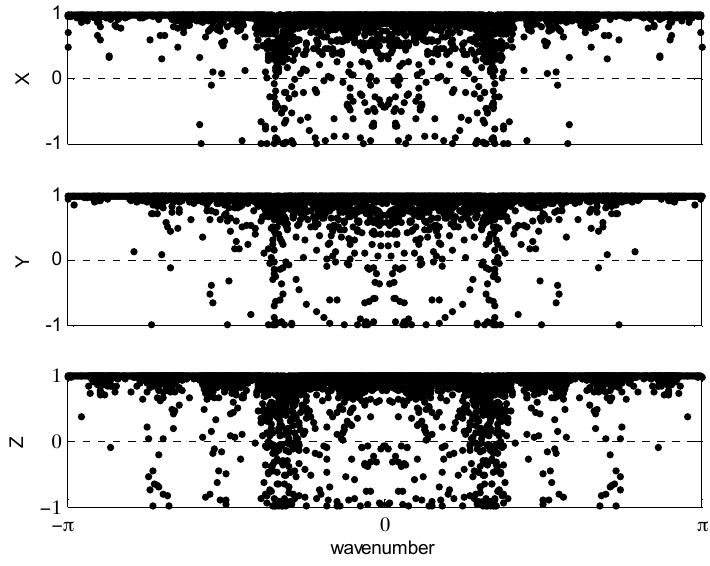
Figure 5. Computed correlation coefficients for each wavenumber.